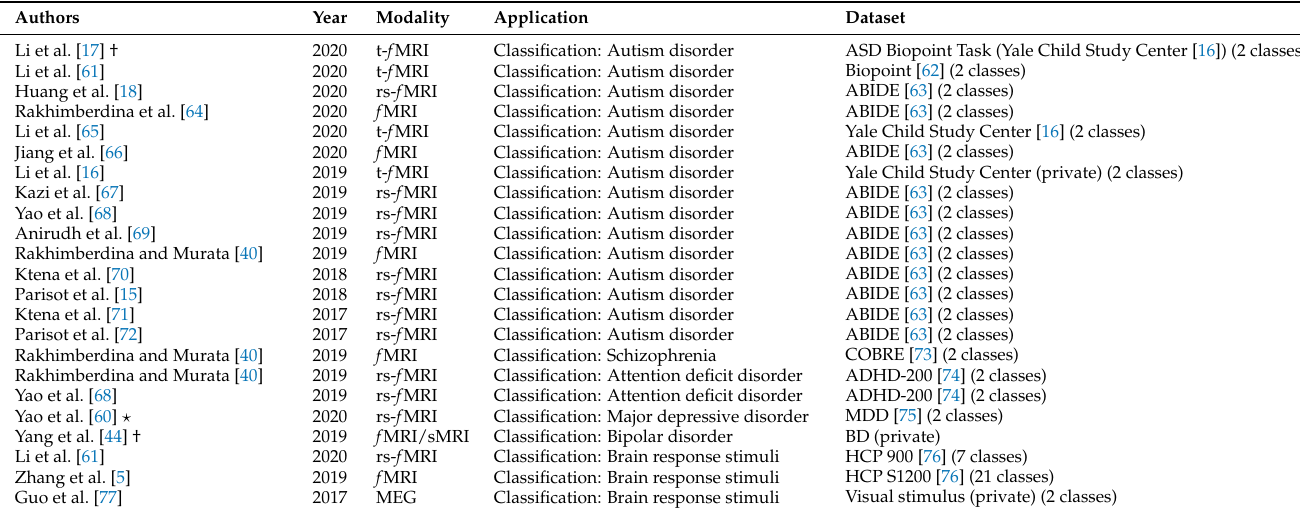
Classification: Brain response stimuli Visual stimulus (private) (2 classes) (cid:63) GCN with temporal structures for medical diagnostic analysis. † GCN with attention structures for medical diagnostic